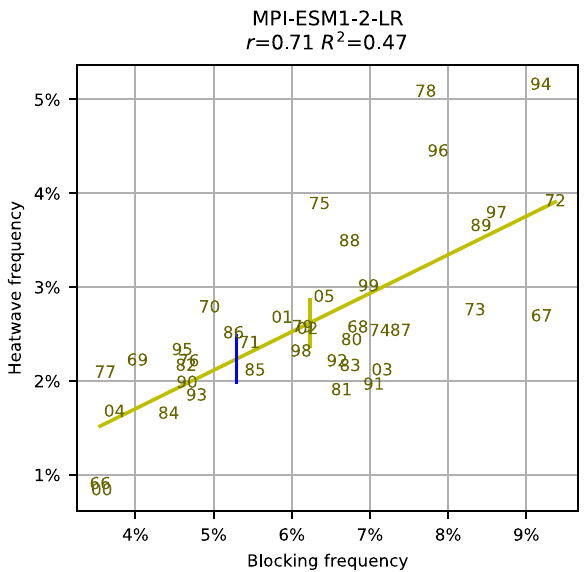
Fig. 1 Optimized blocking index correlates well with heatwave frequency. Scatter plots of heatwave frequency versus optimized blocking index, both averaged over land points north of 40°N, in the MPI-ESM1-2-LR model. Each point represents the mean over one summer (two trailing digits of the year labelled). The ordinary least- squares linear regression line is plotted in yellow. The vertical error bars show the 1 σ ranges in estimating the 10-year-mean heatwave frequency using the mean blocking frequency of the historical run (yellow, 1966 – 2005) and SSP585 run (blue, 2060 – 2099). r and R 2 are shown (based only on one model and therefore slightly deviate from the multi-model mean).